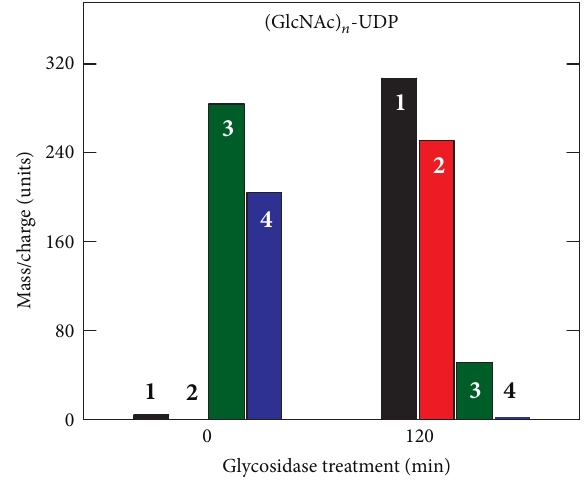
Figure 3: Glycosidase treatment converts larger ( GlcNAc ) 𝑛 -UDP oligomers to GlcNAc-UDP. SeHAS membranes were incubated for 30 min with UDP-GlcNAc alone, Folch extracted, fractionated over a size exclusion column, and samples were either untreated (0 min) or treated (120 min) with jack bean hexosaminidase. The samples were then analyzed by MALDI-TOF MS to identify and quantify m/z signals of candidate oligomeric chitin-UDP fragments corresponding to 𝑛 = 1 –4 (boldface white or black numbers). The presence of chitin linkages was confirmed by the ability of glycosidase treatment to shift species with 3 or 4 sugars to products with 1 (GlcNAc-UDP) or 2 sugars. Additional MS/MS analysis of the starting sample ions (not shown) revealed smaller members of the expected oligomer series, including GlcNAc-UDP.